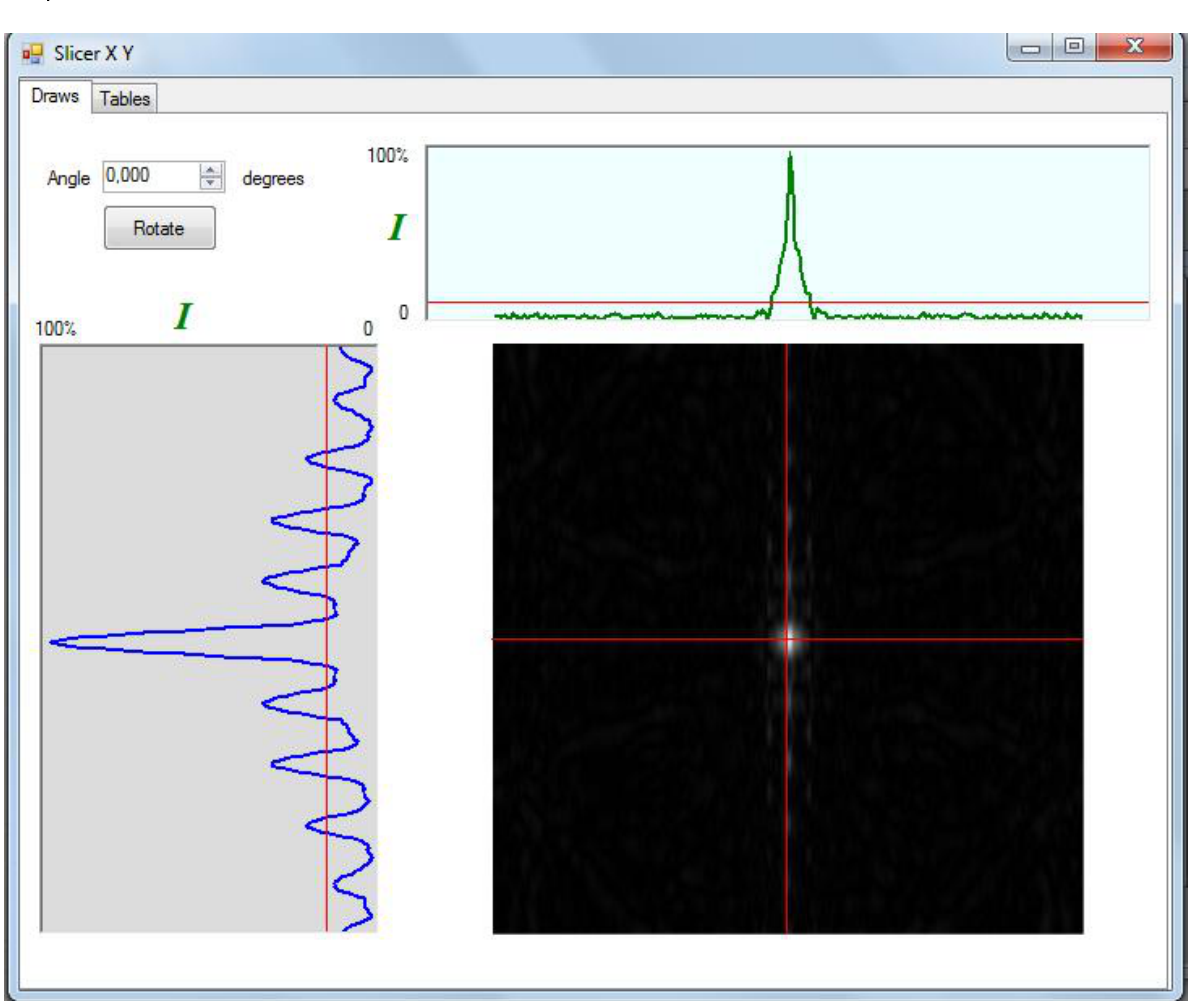
Figure 4. Screenshot of the program automatically detecting distances between units in periodical